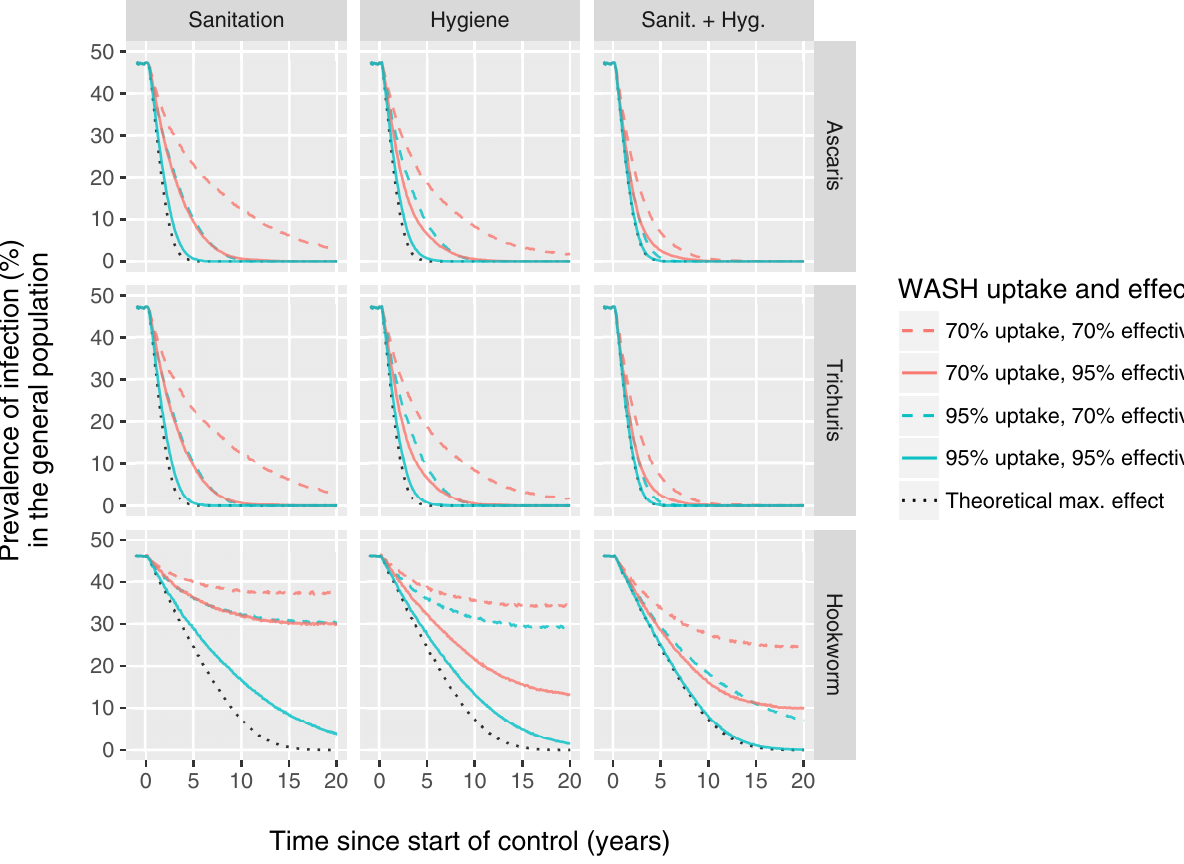
Fig 2. Model-predicted long-term impact of sanitation and hygiene interventions on prevalence of soil-transmitted helminth infection in absence of PCT. Columns of panels refer to different WASH modalities and rows represent the three major soil-transmitted helminth species. Sanitation and hygiene interventions are assumed to reduce the contributions and exposure to the environmental reservoir of infection of individuals who take up the intervention, respectively. Coloured lines indicate different levels of uptake. Different levels of effectiveness (reduction of contribution and/or exposure to the environmental reservoir for individuals that take up the intervention) are indicated by solid vs. dashed lines. The red solid dashed line is based on the same assumptions about WASH uptake and effectiveness used for Fig 1. The dotted black line represents a theoretical scenario where the WASH modality (of that column of panels) is perfectly implemented and taken up, reducing exposure and/or contribution to transmission by 100% for all individuals. Predicted infection prevalences (y-axis) represent results from a single Kato-Katz slide. See S3 Fig for similar figures for a wider range of levels of uptake and effectiveness.